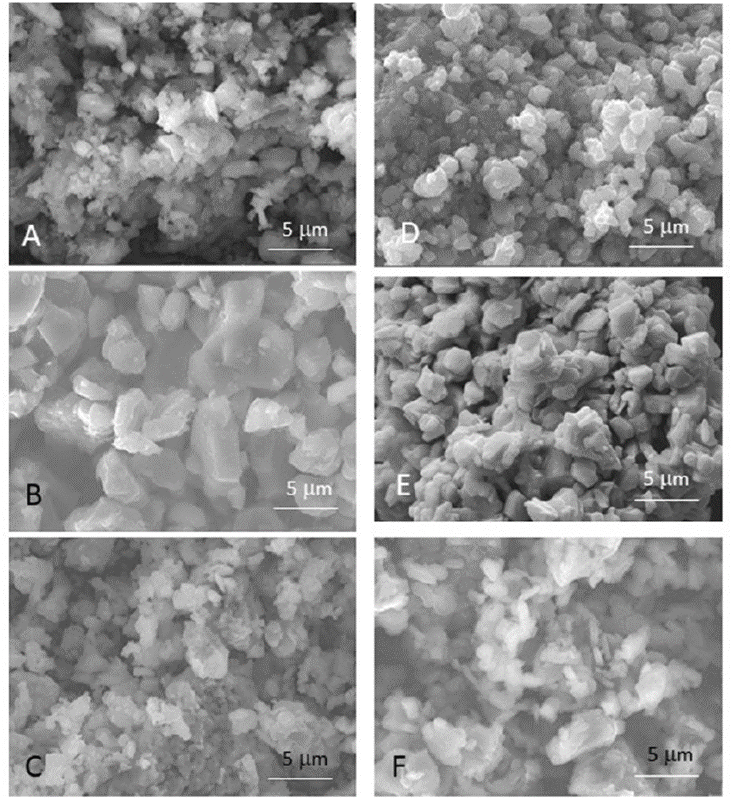
Figure 2. SEM images of slowly cooled ( A – C ) and quenched ( D – F ) NMO, Cu02, and Fe02 samples (from top to bottom).